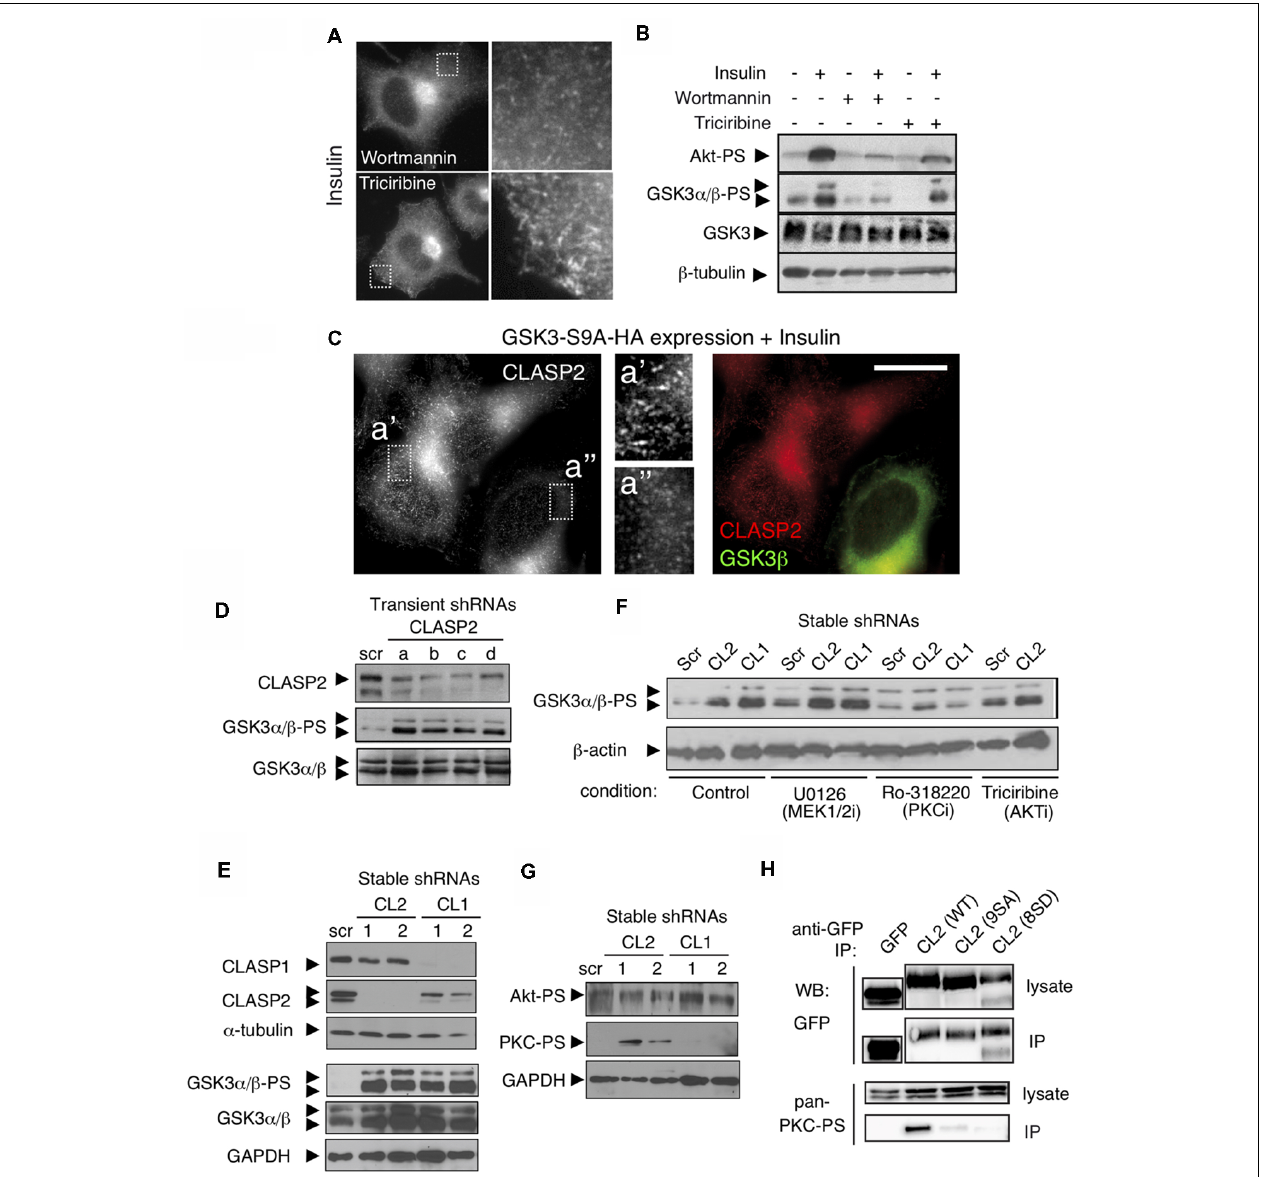
FIGURE 4 | Knockdown of the CLASPs reveals a role in feedback loop signaling. (A) Inhibition of PI3K but not of Akt, blocks Insulin-induced binding of CLASP2 to MT plus-ends. CLASP localization was assessed by IF in serum starved insulin-treated (2 µ g/ml for 10 min) N1E-115 cells, pretreated with Wortmannin (PI3K inhibitor, 100 nM, 30 min) or Triciribine (Akt inhibitor, 10 µ M, 30 min). (B) Insulin induces an increase in serine phosphorylation of GSK3 α / β , downstream of PI3K but not of Akt, in N1E-115 cells. Western blots (WBs) show Insulin-mediated signaling in serum starved N1E-115 cells, pretreated with PI3K or Akt inhibitors. We used antibodies against Akt-PS (Ser473), GSK3 α / β -PS (Ser9/Ser21), total GSK3 and β -tubulin. (C) Active GSK3 β abolishes CLASP2 relocalization to MT plus-ends induced by Insulin. N1E-115 cells were transfected with constitutively active GSK3 β (GSK3 β -S9A-HA), treated with Insulin as above, fixed 48 h post-transfection, and double stained with anti-HA (green in merge, to stain active GSK3 β ) and anti-CLASP2 (red in merge). (D) Transient knockdown of CLASP2 increases GSK3 serine phosphorylation. N1E-115 cells were transfected with the indicated shRNA constructs. After 72 h, cells were lysed and the levels of the indicated proteins examined by WB. (E) Stable depletion of CLASP1 and -2 enhances GSK3 serine-phosphorylation. N1E-115 cells were transfected with the indicated shRNA constructs and selected with puromycin. Resistant clones were picked and examined for CLASP1 or -2 knockdown. In two of each, we next examined the levels of phosphorylated and total GSK3 by WB. (F) Inhibition of protein kinase C (PKC) alleviates CLASP-depletion-mediated GSK3 phosphorylation. Stable N1E-115 clones expressing the indicated shRNAs were treated with inhibitors (i) against MEK1/2 (U0126, 1 µ M, 30 min), PKC (Ro318220, 0.5 µ M, 30 min), or Akt (Triciribine, 10 µ M, 30 min). Cells were subsequently lysed and the levels of the indicated proteins examined by WB. (G) Depletion of CLASP2—but not of CLASP1—leads to increased phosphorylation of atypical PKC (aPKC) but not of Akt. N1E-115 clones stably-depleted in CLASP1 or CLASP2 were lysed and the levels of the indicated phospho-proteins (Akt-PS and PKC-PS) were examined by WB (H) Interaction of CLASP2 with phosphorylated aPKC. N1E-115 cells were transiently transfected with wild type (WT) GFP-CLASP2 [CL2 (WT)], GFP-CLASP2-9SA, or with GFP-CLASP2-8SD. After 1 day, cells were lysed and the GFP-tagged forms of CLASP2 were pulled-down with anti-GFP antibodies. Lysates and co-IPs were examined by WB using antibodies against the indicated proteins.